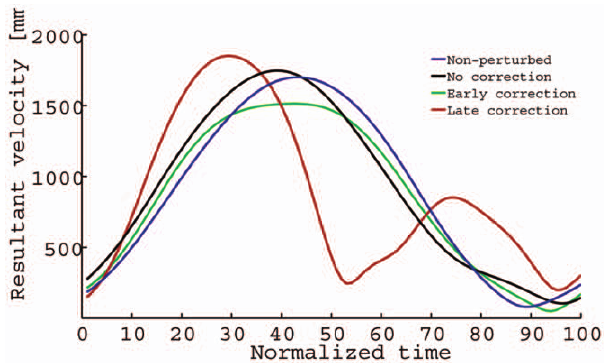
Figure 6. Representative absolute maximum grip aperture profiles during the reach-to-grasp